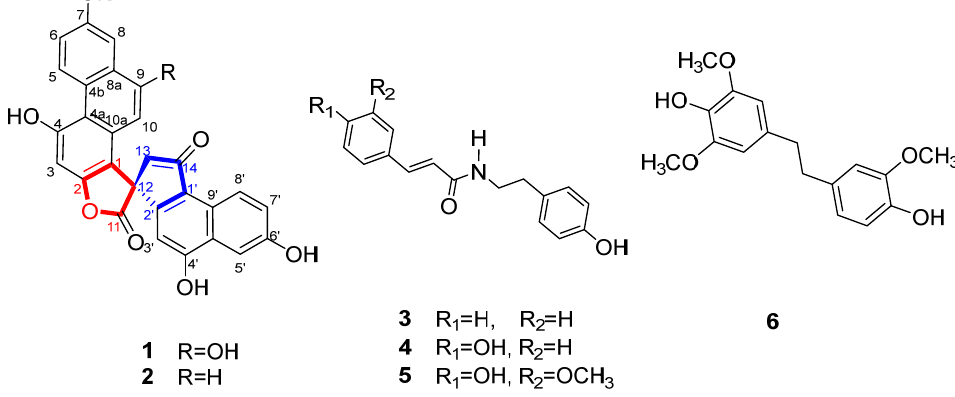
Figure 1. Structures of compounds 1 − 6.